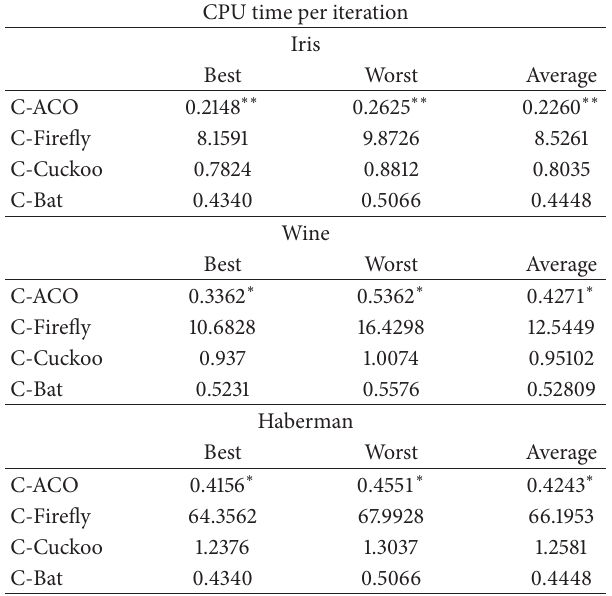
Figure 6: Computation time (in secs.) for C-ACO algorithm. Table12:ComparisonofalgorithmswithrespecttoCPUtimetaken per iteration.